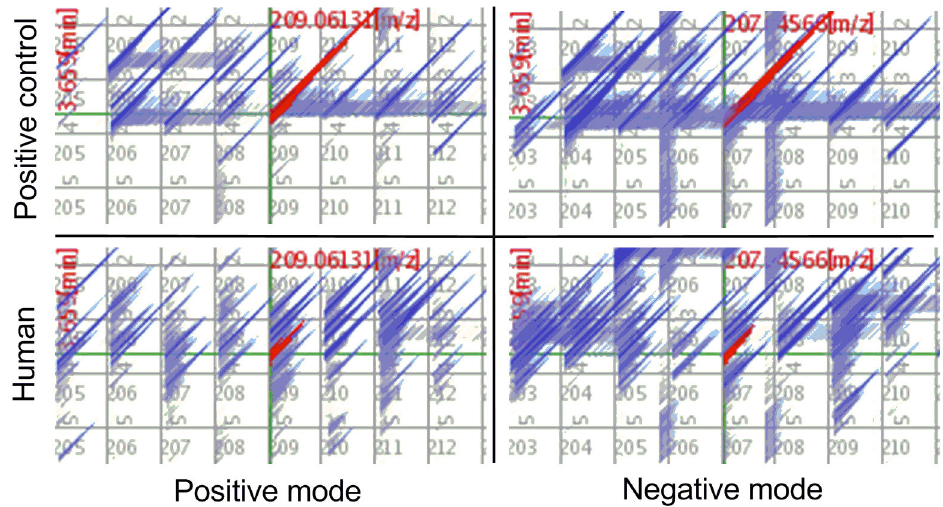
Figure 2. Representative mass chromatograms of LC/TOFMS for N -desmethyl-acetamiprid (AM-2) (red): The X-axis is molecular weight and the Y-axis is retention time. The upper row is for the positive control and the lower row is for the human urine (#1). The left column is positive mode and the right column is negative mode.